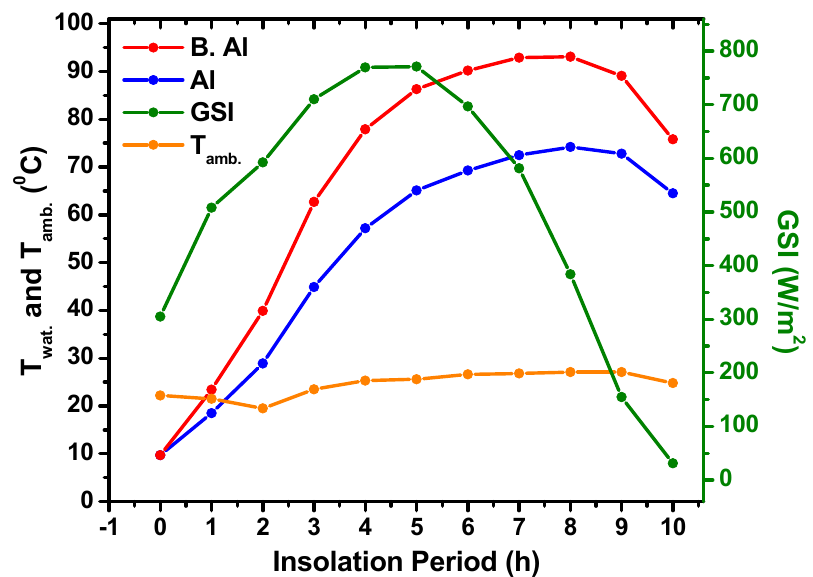
Figure 4. Water and ambient temperatures (T wat . and T amb .) and global solar intensity (GSI) against insolation period for solar heating of Al and B. Al of 1 mm thickness; starting time: 8:00 a.m.; sunny day; date: 30/09/2021, Amman, Jordan.